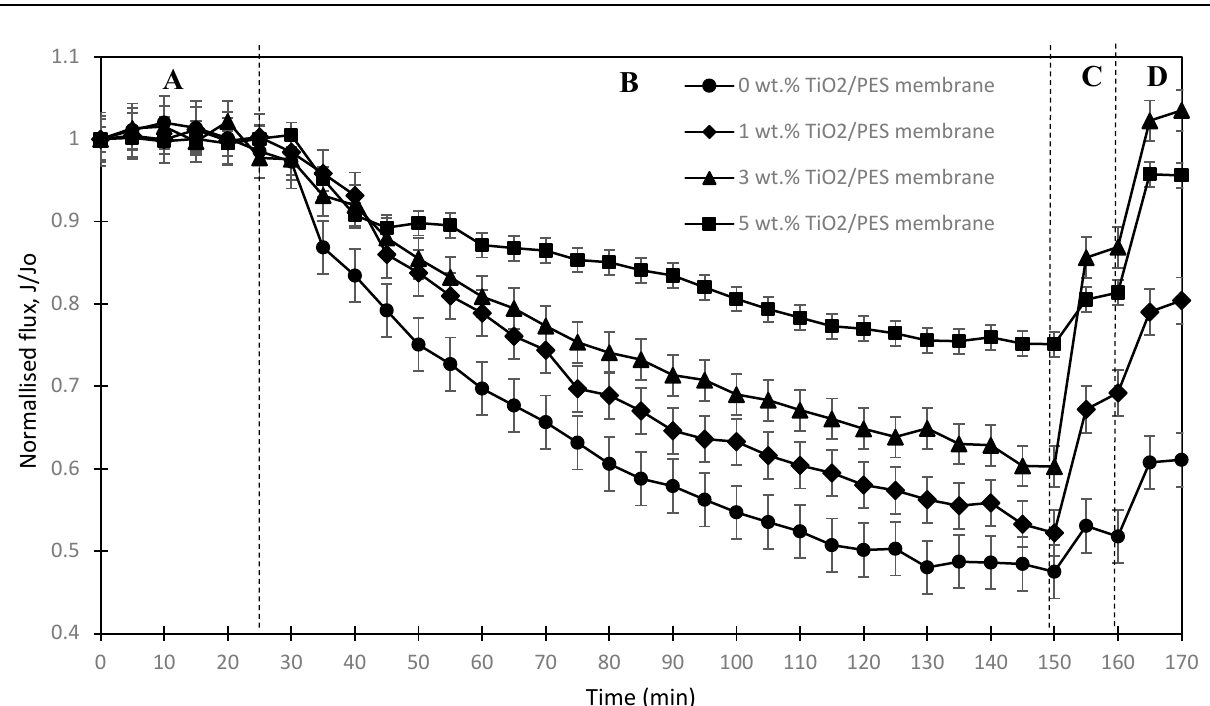
Time (min) Figure 7. Graph of normalised flux versus time for different TiO 2 /PES mixed matrix membrane concentrations. (Region A: Feed with DI water to allow the membrane to reach quasi-equilibroum steady state; Region B: HA filtration process; Region C: membrane cleaning process (DI water); Region D: Membrane cleaning process (UV irradiation plus water cleaning)).